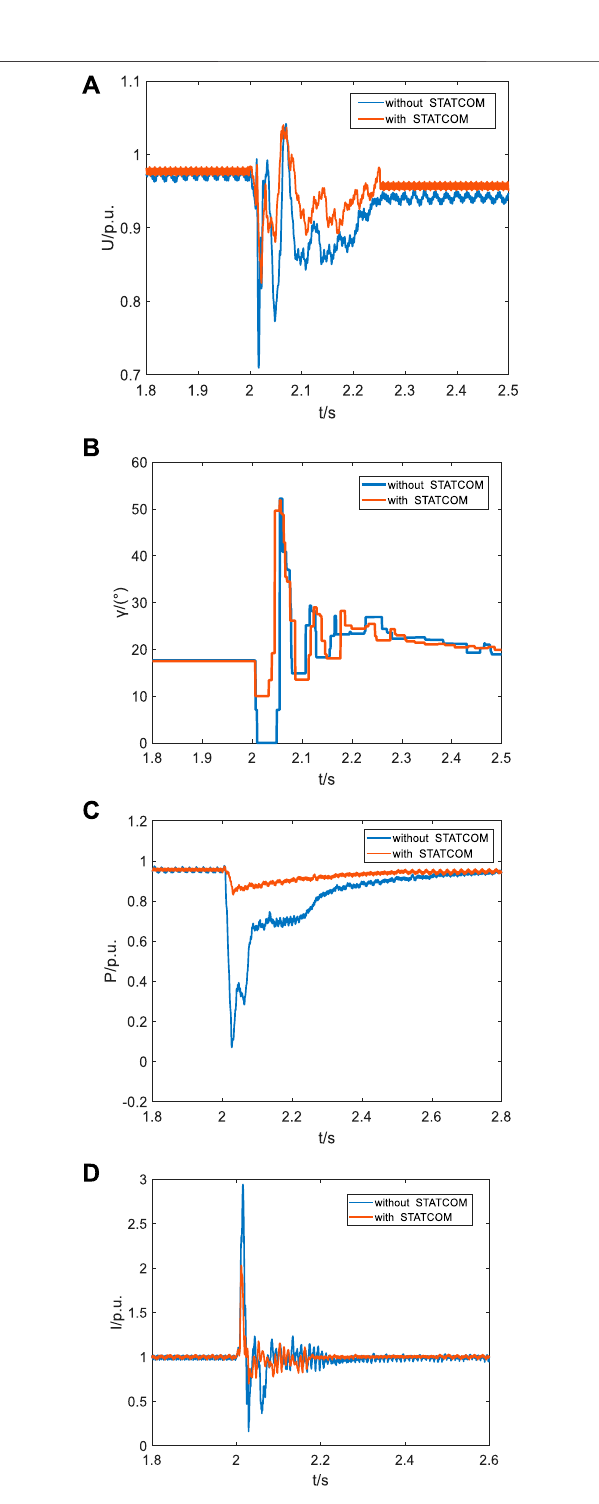
FIGURE 10 | Typical characteristic quantities of single-phase faults. (A) Effective value of AC voltage on inverter side in single-phase fault. (B) Extinction angle of commutation failure in single-phase fault. (C) System transmission power in single-phase fault. (D) System DC current in single-phase